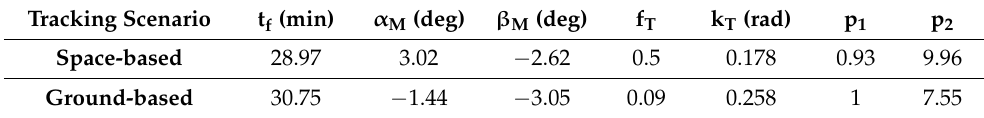
Table 9. Generated control parameters for thrust directions.